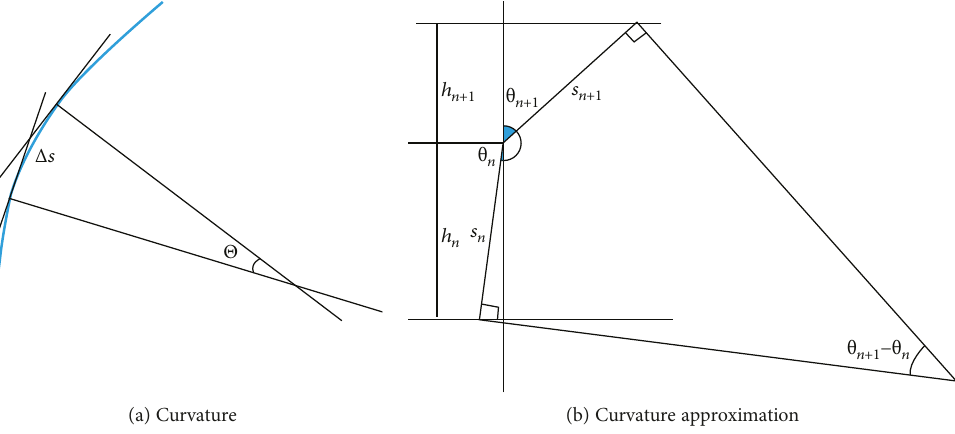
Figure 6: Schematic diagram for curvature